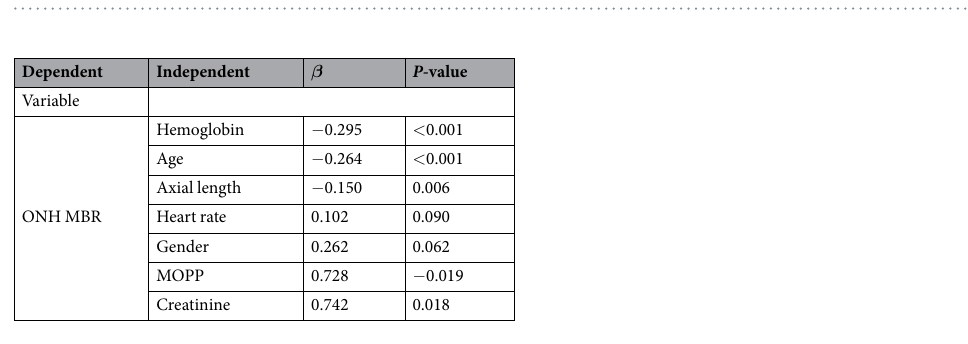
Table 4. Result of multiple stepwise regression analysis for independence of factors including laboratory data contributing to ONH MBR. ONH: optic nerve head; MBR: mean blur rate; MOPP: mean ocular perfusion pressure.